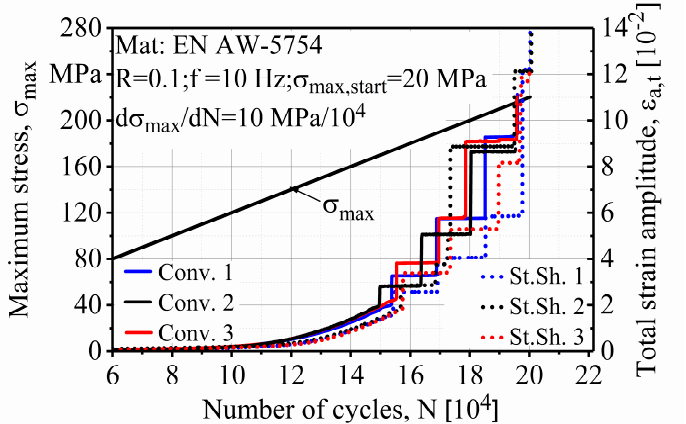
Figure 8. Comparison of all of the load increase test (LIT) on conventional and stationary shoulder FSW specimens. Metals 2020 , 10 , x FOR PEER REVIEW